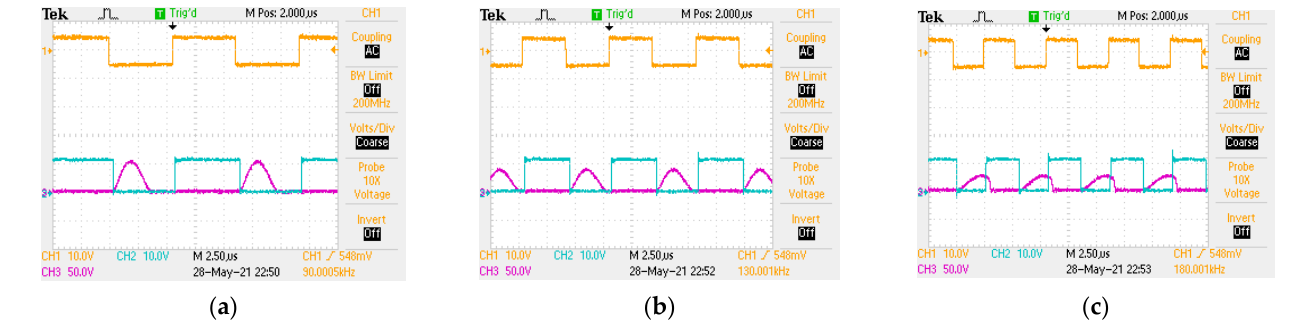
Figure 12. Waveform across the shunt capacitor for frequency ( a ) 90 kHz, ( b ) 130 kHz, ( c ) 180 kHz.